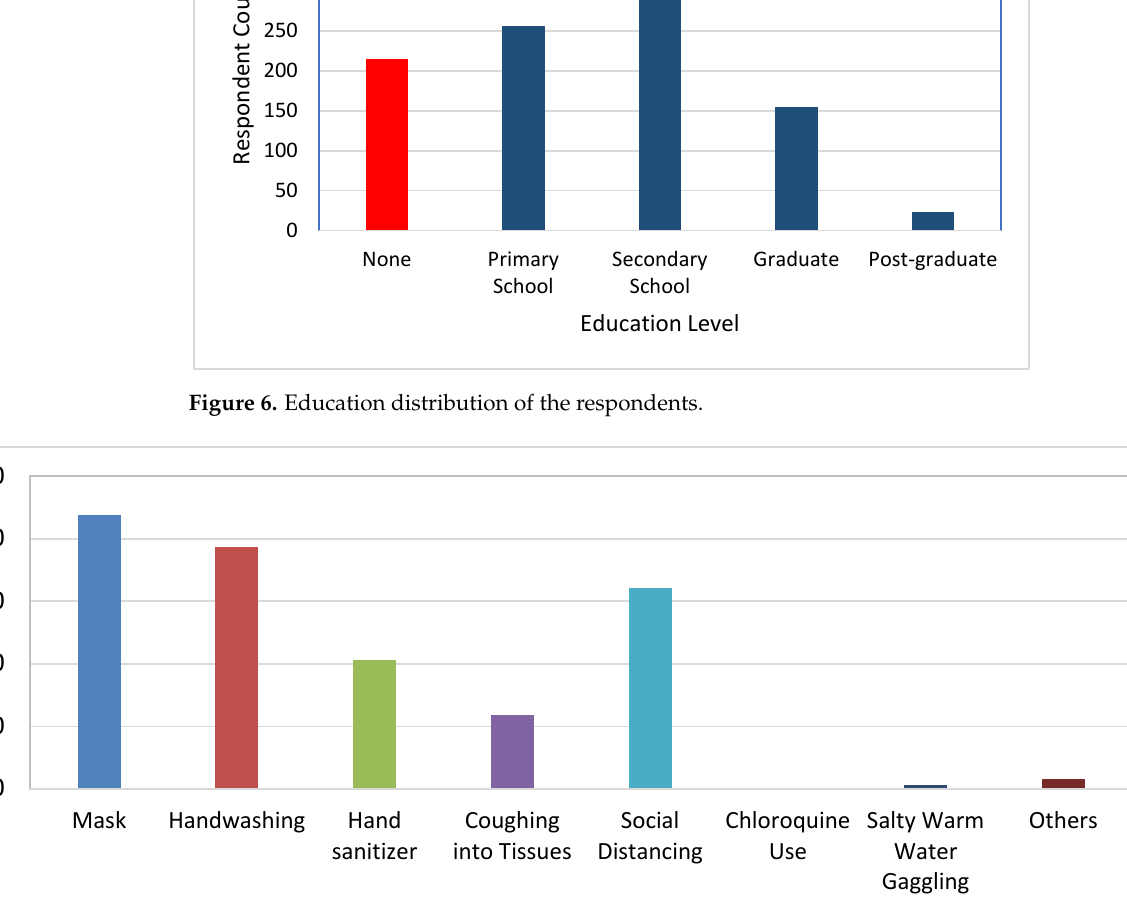
Figure 7. Distribution of the protective behaviors of the respondents.